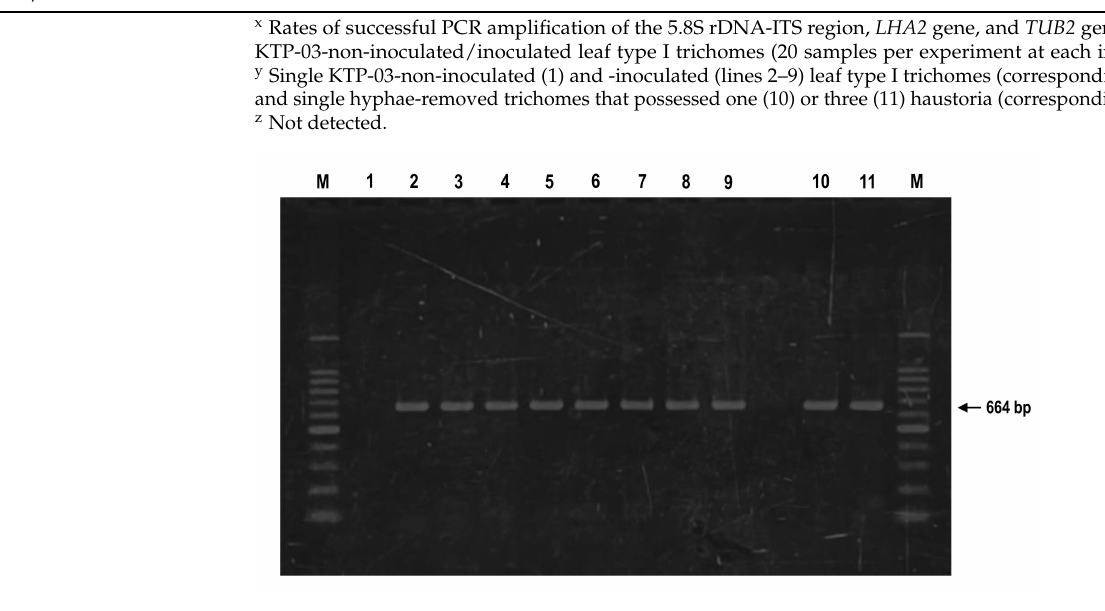
Figure 5. Electrophoretic detection of the amplified 5.8S rDNA-internal transcribed spacer (ITS) region of KTP-03 conidia inoculated onto single leaf type I trichome cells of tomato cv.